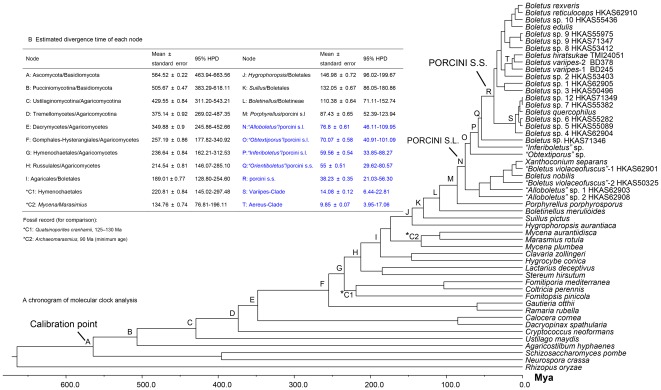
Chronogram and estimated divergence times of porcini s.l. generated from molecular clock analysis using the RPB1-nrLSU data.Chronogram obtained using the Ascomycota – Basidiomycota divergence time of 582 Mya as the calibration point is shown in panel A. The calibration point and objects of this study are marked in the chronogram. The geological time scale is in millions of years ago (Mya). Estimated divergence times of main nodes are summarized in panel B, with divergence times of lineages in the porcini s.l. highlighted in blue color.